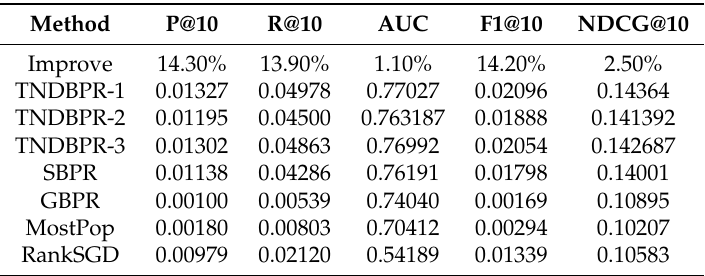
Table 2. Comparison results on Epinions dataset.